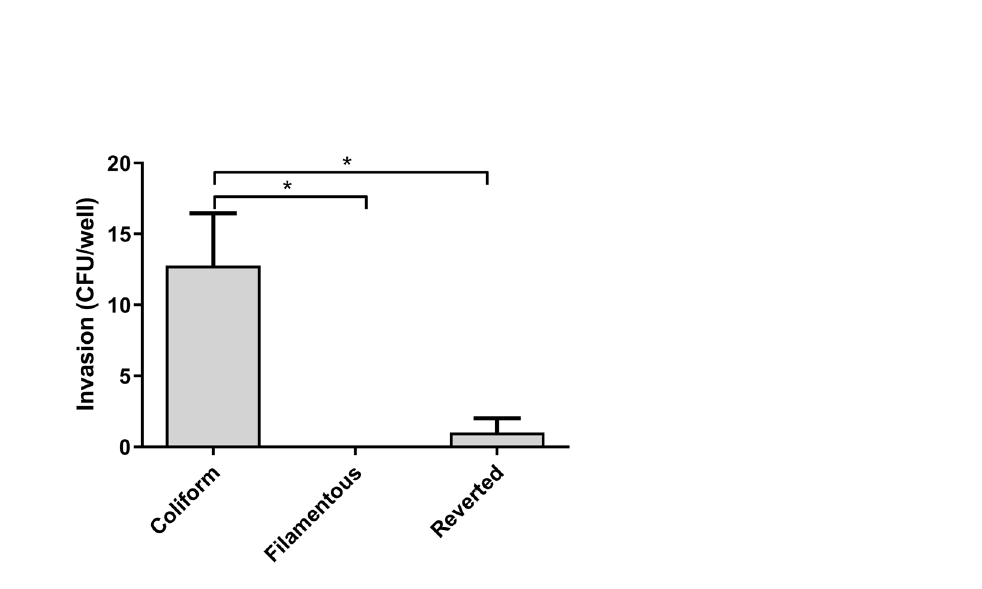
Figure 6. The human bladder epithelial cell line HBLAK was infected in 24-well plates with Coliform, Filamentous and Reverted bacteria followed by evaluation of bacterial invasion. Bacterial invasion was assessed and quantified as the number of intracellular bacteria (CFU)/well. Data are presented as mean ± SEM of four independent experiments. Statistical significance * p <